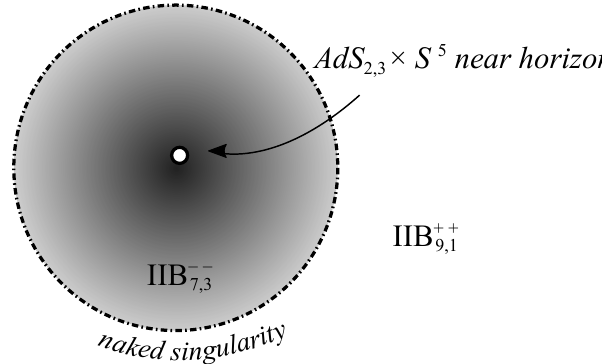
Figure 10 . The near horizon geometry of negative branes lies within the bubble of exotic string theory surrounding the